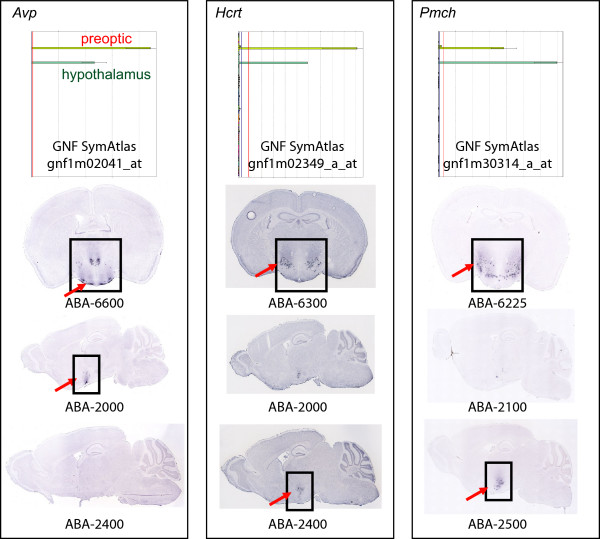
Gene expression of Avp, Hcrt, and Pmch. While little difference in expression among these genes is shown in the GNF mouse tissue atlas, the ABA images offer a better resolution and suggest Avp may play a different biological role than Hcrt and Pmch. The black boxes outline the brain hypothalamus region. Avp expression is concentrated in a specific hypothalamus region called periventricular region, while expressions of Hcrt and Pmch are largely concentrated in a different hypothalamus region called lateral hypothalamic area. Brain images were obtained from the ABA database and the tissue gene expression data were obtained from GNF SymAtlas.